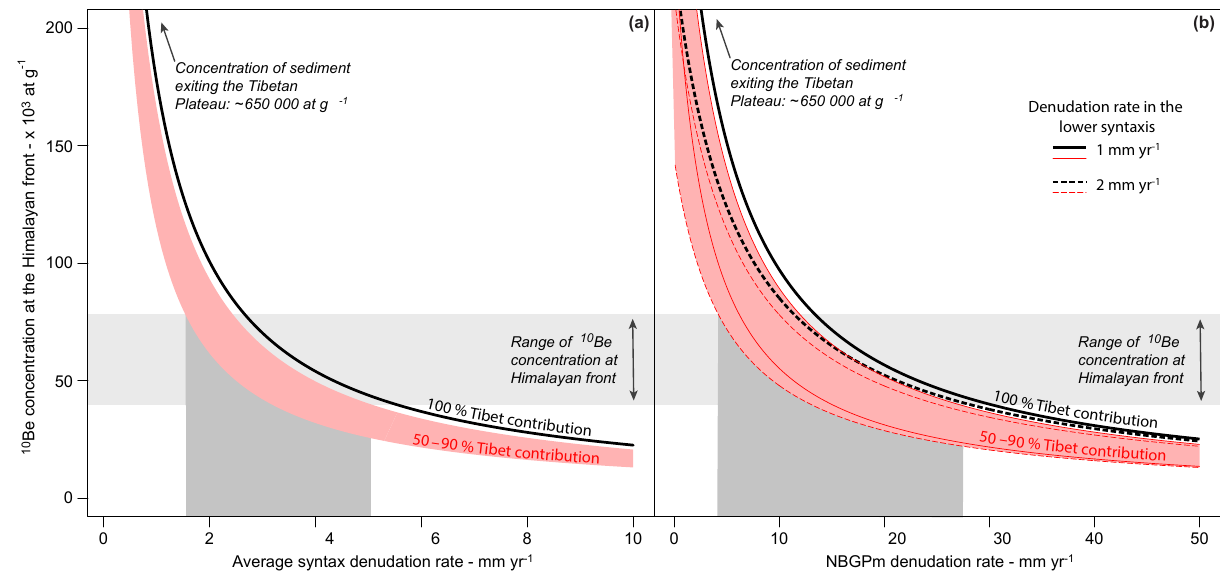
Figure 9. 10 Be concentration mixing model. (a) The concentration of sediments exported at the Himalayan front (pts. 7–8) is calculated by mixing sediments from the Tibetan Plateau (pt. 3) with sediments produced along the entire syntaxis (pts. 3 and 7–8) for a range of denudation rates in the syntax. (b) The mixing model is calculated for variable denudation rates within the restricted area of the NBGPm, mixing with sediments exported by the Tibetan Plateau, tributaries within the syntaxis (pts. c, d, e) as well as for two estimates of denudation rates in the lower part of the syntaxis (1 and 2mmyr − 1 ). The 10 Be concentration modeled at the Himalayan front is then compared to the 10 Be concentrations actually measured (pts. 7–8) in order to constrain the range of possible denudation rates in the entire syntaxis (a) and the NBGPm (b) . The solid and dashed black curves are the modeled concentrations assuming that 100% of the sediment flux predicted by the TCN is exported by the Tibetan part of the catchment. However, as discussed in the text, sediment storage and lower quartz abundances imply fluxes that are likely only 50 to 90% of the TCN-derived flux. The model results for a reduced Tibetan contribution are shown by the red shaded area and result in lower denudation rate estimates for the entire syntaxis ( a 1.8 to 5.1myr − 1 ) and the NBGPm ( b 4 to 27mmyr − 1